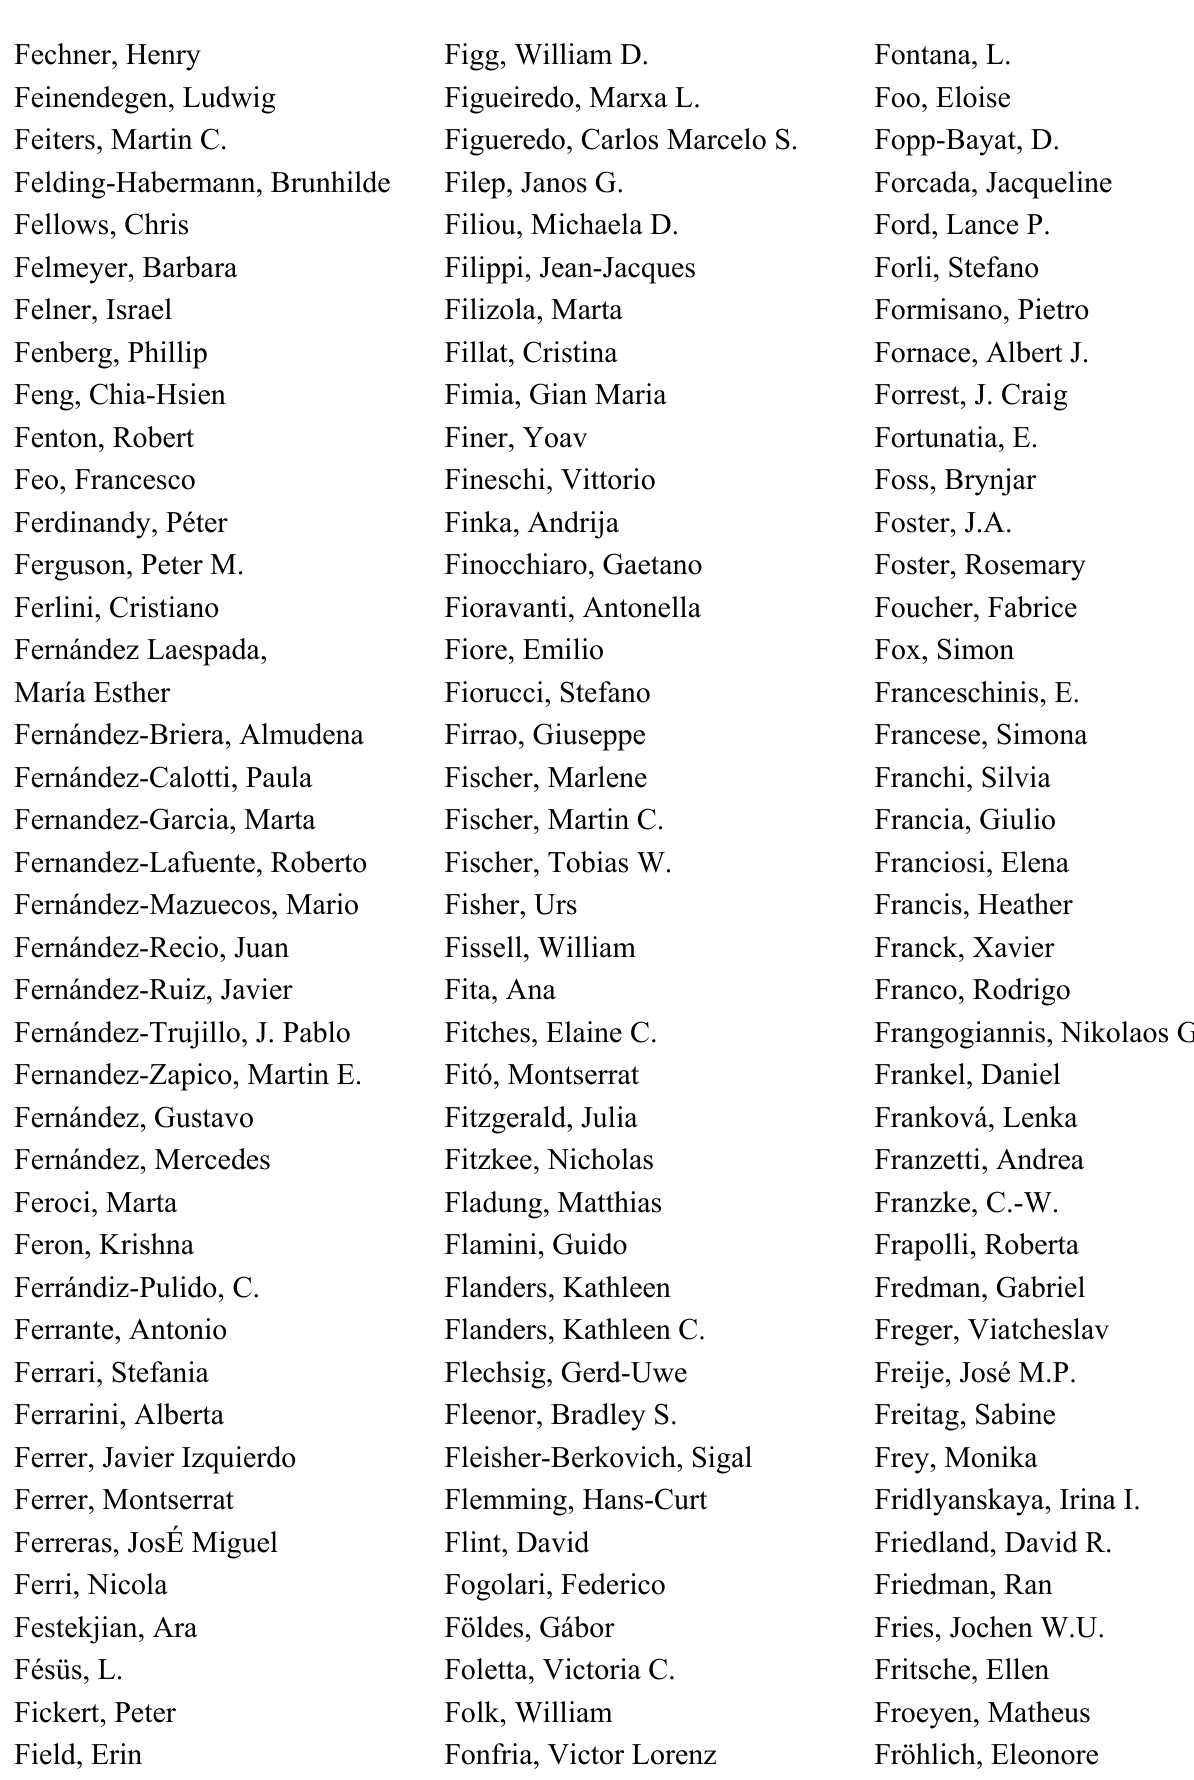
Figg, William D. Figueiredo, Marxa L. Figueredo, Carlos Marcelo